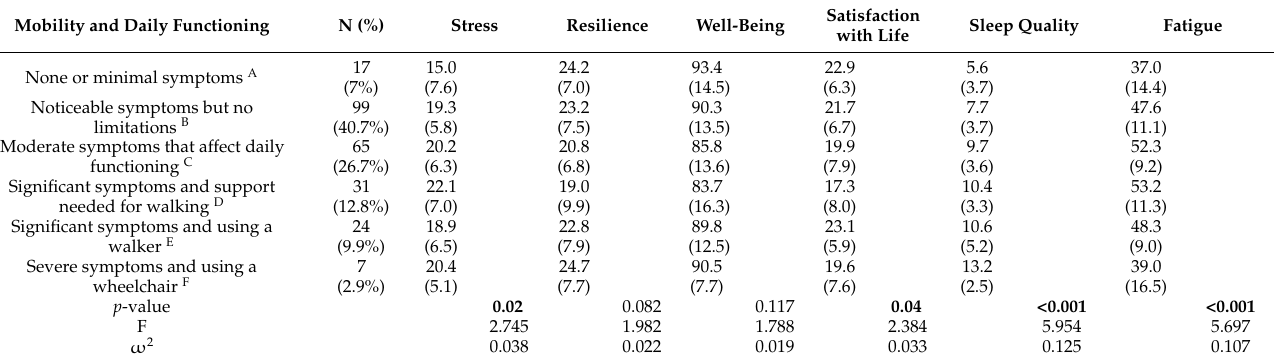
Table 2. Mobility and Daily Functioning in relation to the dependent